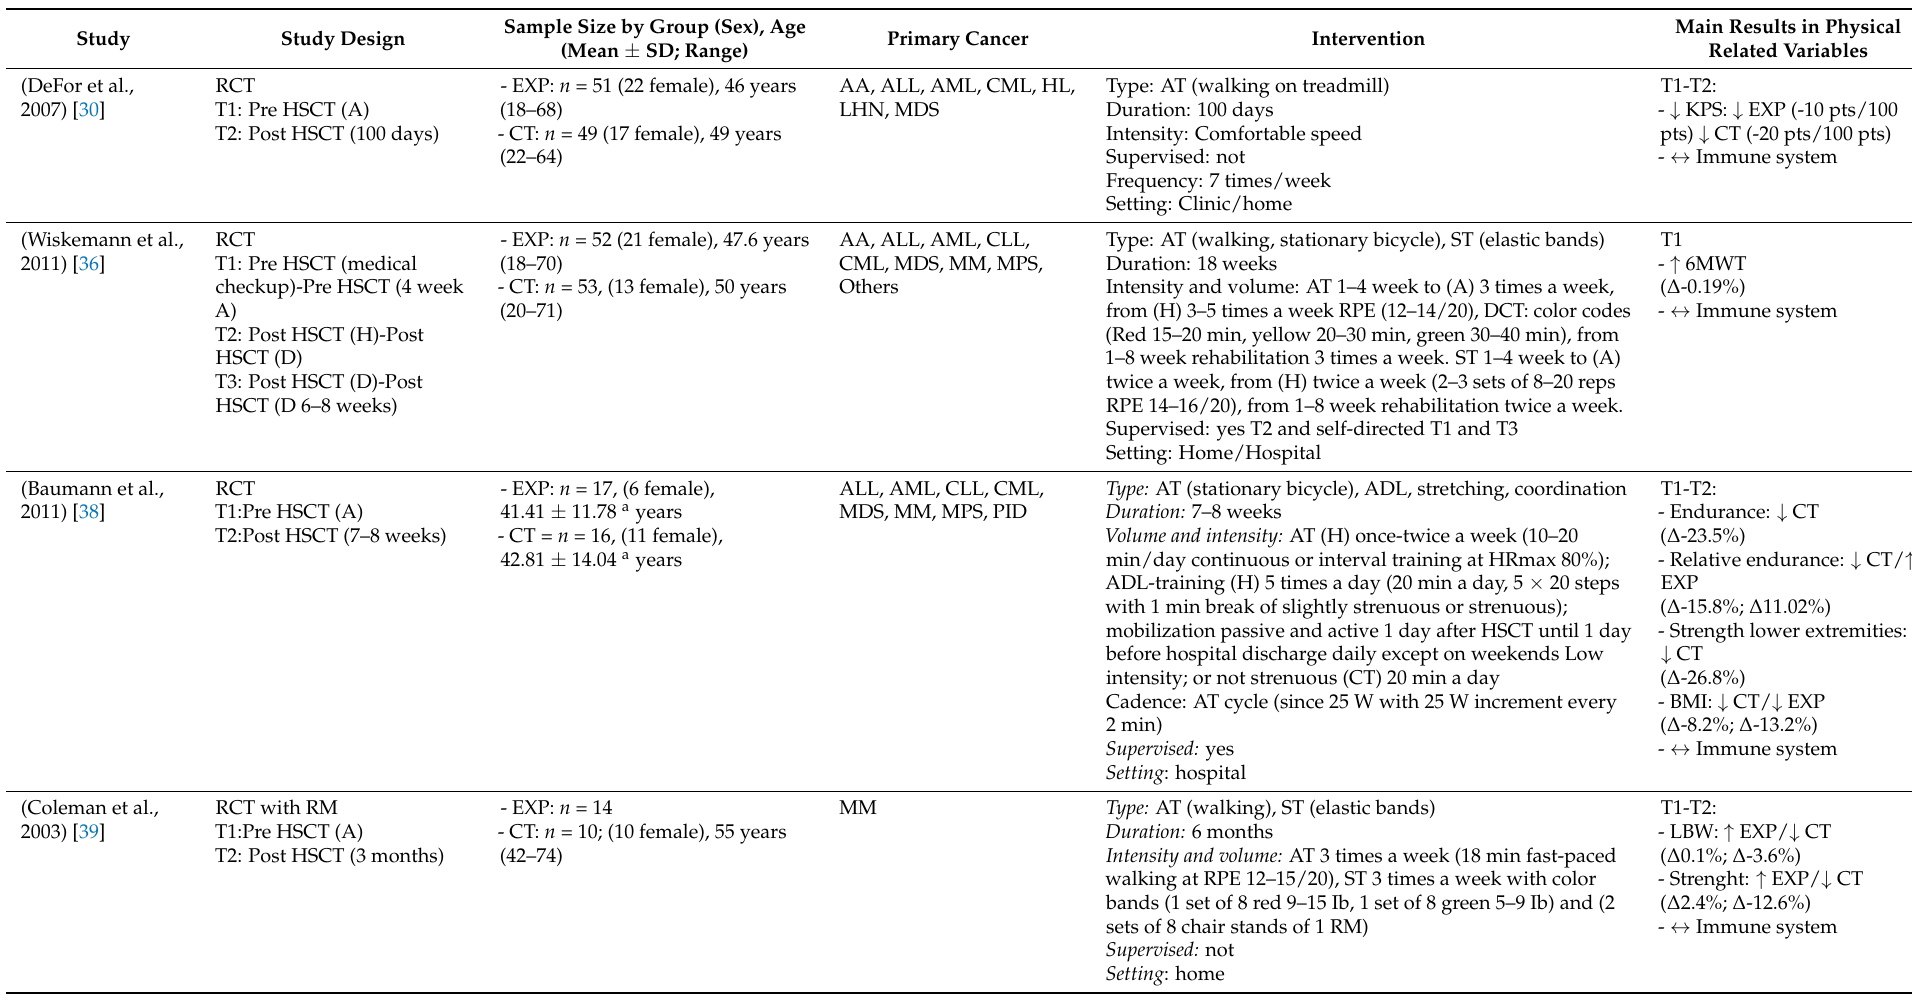
Table 2. Studies that have analyzed the effects of an exercise program before and after HSCT, with main results in physically related variables. Study Study Design Primary Cancer Intervention